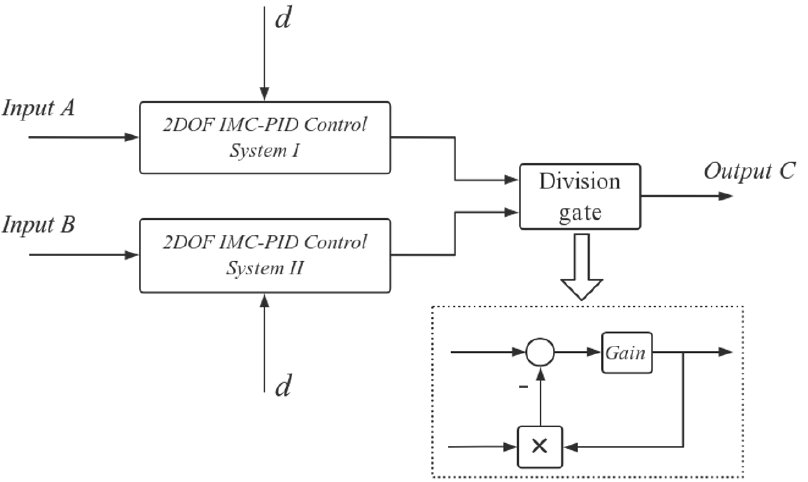
Figure 14. The 2DOF IMC-PID division gate control system.